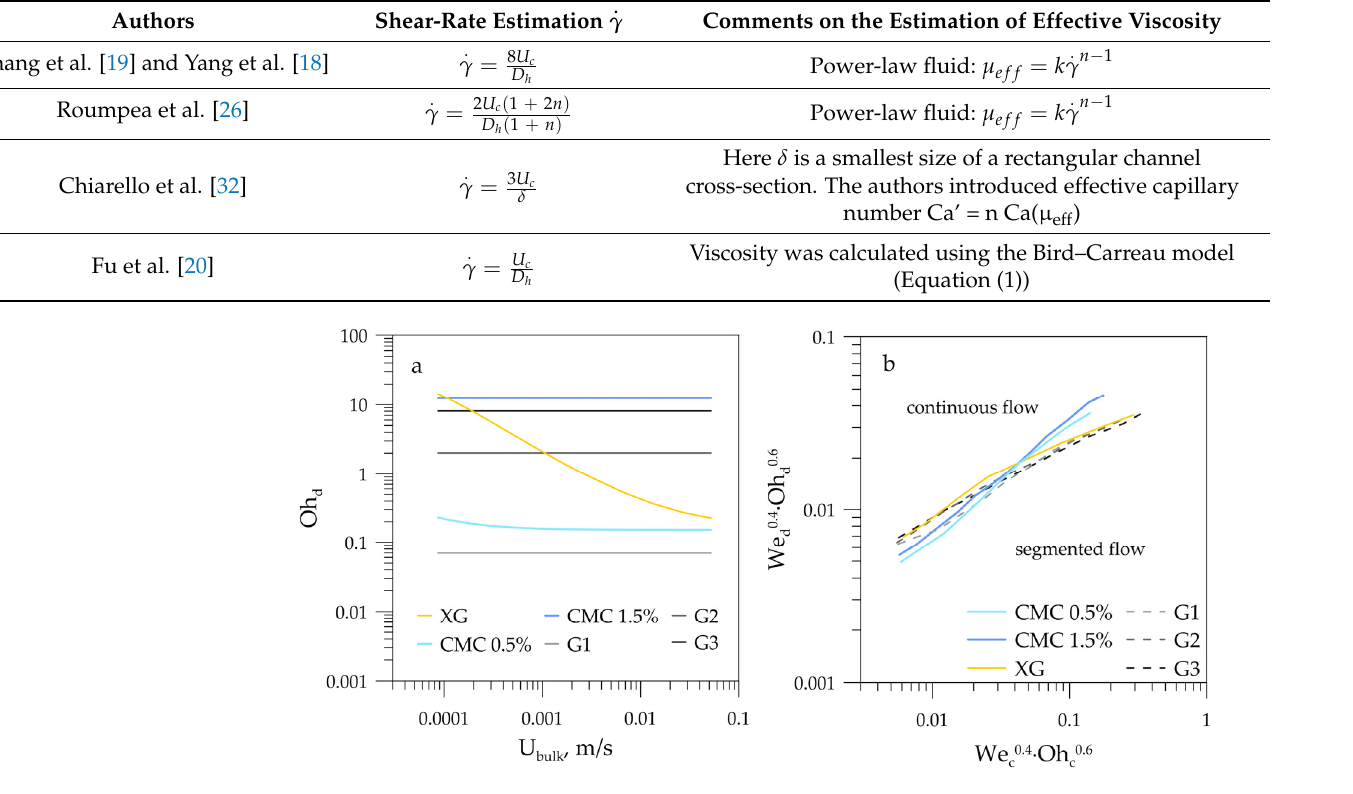
Figure 6. ( a ) Ohnesorge numbers for Newtonian and non-Newtonian dispersed phases as a function of bulk velocity; ( b ) boundaries between segmented and continuous-flow rates for liquid–liquid flows with Newtonian and non-Newtonian dispersed phases in terms of the proposed nondimensional complex.